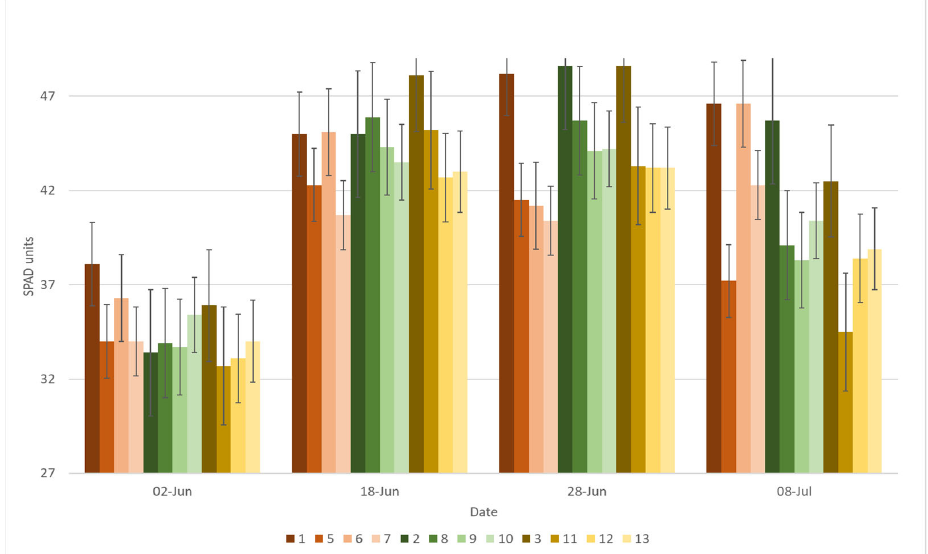
Figure 2. SPAD value of field pea in different treatments, averaged over the three years, depending on the vegetation date. Note: 1, Pea J ū ra DS; 2, Pea Egle DS; 3, Pea Lina DS; 4, Oat Viva DS; 5, Pea J ū ra DS 50% + 50% oat; 6, Pea J ū ra DS 60% pea + 40% oat; 7, Pea J ū ra DS 70% + 30% oat; 8, Pea Egle DS 50% + 50% oat; 9, Pea Egle DS 60% pea + 40% oat; 10, Pea Egle DS 70% + 30% oat; 11, Pea Lina DS 50% + 50% oat; 12, Pea Lina DS 60% pea + 40% oat; 13, Pea Lina DS 70% + 30% oat.